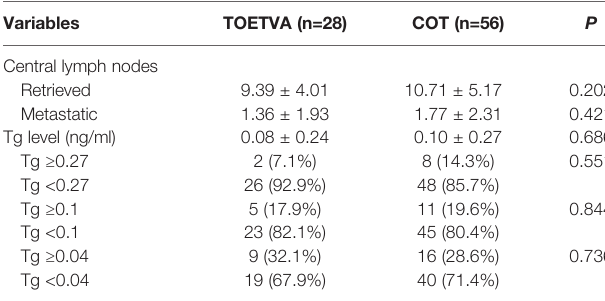
TABLE 2 | Surgical completeness (N=84).